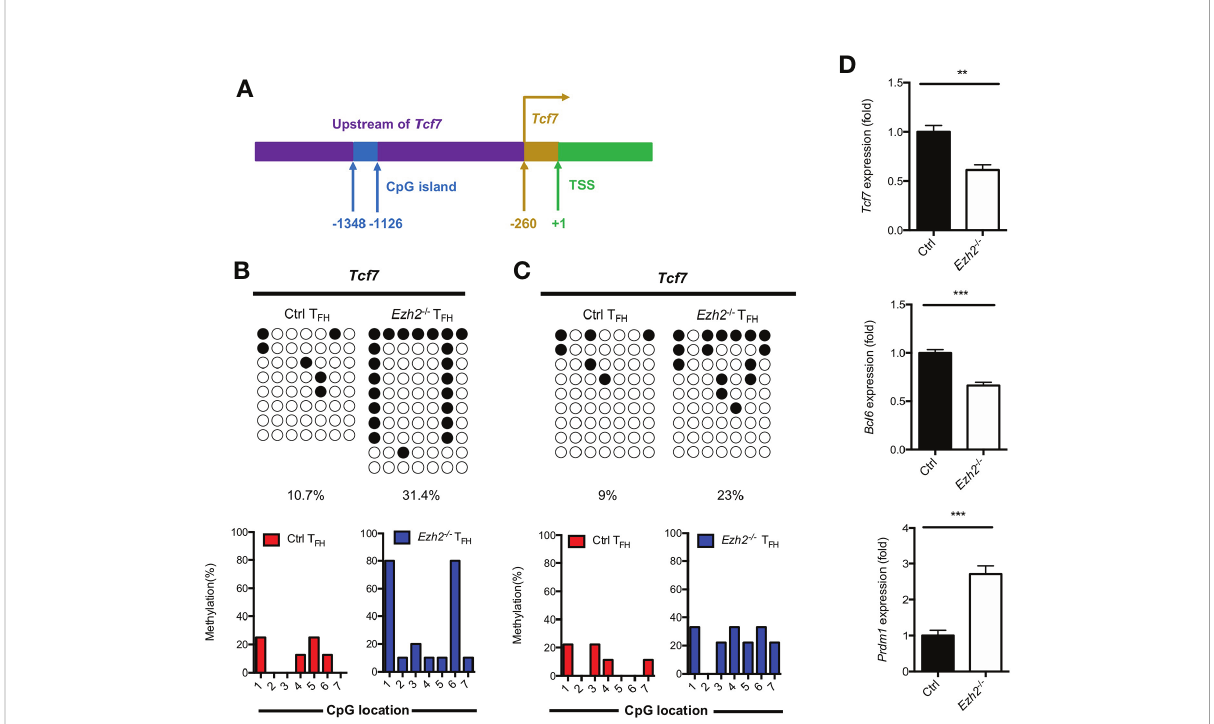
FIGURE 3 EZH2 deletion elevates the DNA methylation level at the Tcf7 locus. (A) Schematic diagram of CpG island in Tcf7 gene promoter. (B) Bisul fi te sequencing analysis and graphical summary of conversed CpG island of Tcf7 promoter from sorted T FH cells from control and Ezh2 -/- mice at day 8 after infection. (C) Bisul fi te sequencing analysis and graphical summary of CpG island of Tcf7 promoter from sorted T FH cells from control and Ezh2 -/- mice at day 4 after infection. (D) Real-Time PCR analysis of Tcf7 , Bcl6 , Prdm1 mRNA of T FH cells sorted from control and Ezh2 -/- mice at day 4 after infection. Normalized to their expression in control T FH cells. The horizonal lines were corresponding to the colonies selected for sequencing. Filled black circles indicate methylated cytosine, open white circles indicate nonmethylated cytosine. P value was calculated by unpaired two-tailed Student ’ s t test. Error bars indicate mean ± SEM, ** P < 0.01, *** P <